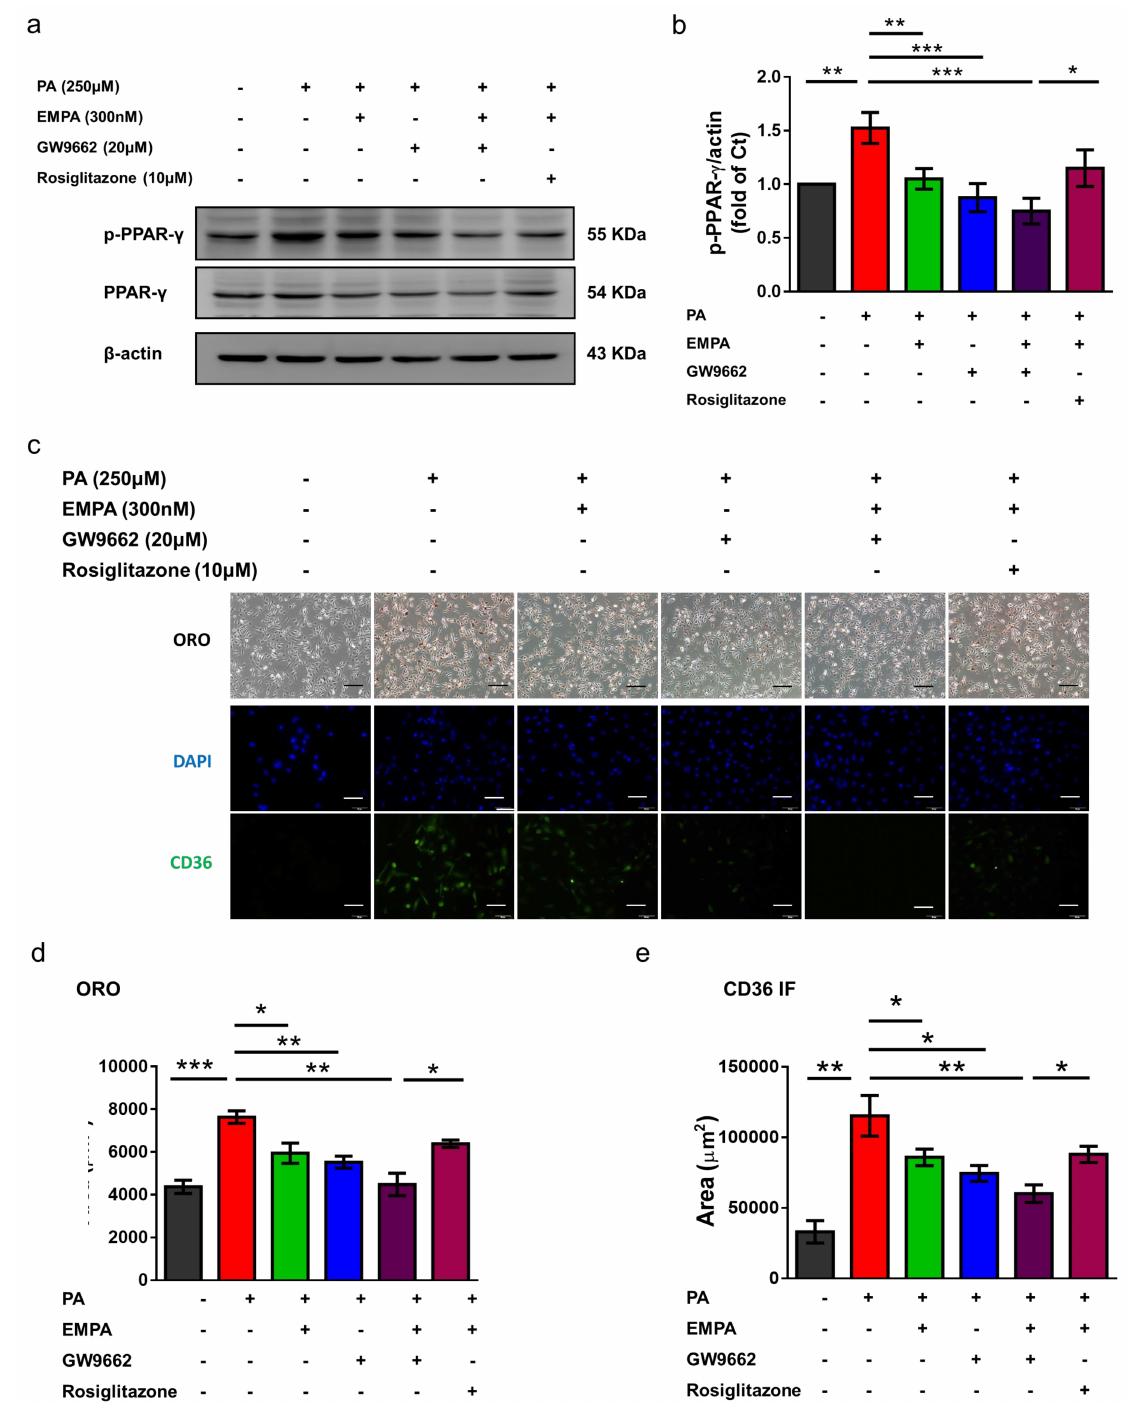
Figure 7. Empagliflozin mediates CD36 expression and reduces lipid accumulation via PPAR- γ phosphorylation in HK-2 cells. HK-2 cells were cultured in a medium with 1% bovine serum albumin, PA (250 µ M), empagliflozin (300 nM), GW9662 (20 µ M), and rosiglitazone (10 µ M). ( a , b ) Western blotting reveals that empagliflozin and GW9662 attenuate PA-induced PPAR- γ phosphorylation, and rosiglitazone can reverse this effect. ( c , d ) Based on representative Oil red O-stained images, GW9662 and empagliflozin attenuate PA-induced lipid droplet deposition, and rosiglitazone can aggravate this parameter (Scale bars = 50 µ m). ( c , e ) Based on the immunofluorescent assessment, GW9662 and empagliflozin attenuate PA-induced CD36 upregulation, and rosiglitazone can reverse this effect. The histograms represent mean ± standard error (SE) from 6 experiments. Statistical analysis was performed with one-way ANOVA. * p < 0.05, ** p < 0.01, *** p < 0.001. EMPA, empagliflozin; IF, immunofluorescence; ORO, Oil red O; PA, palmitic acid; PPAR, peroxisome proliferator-activated